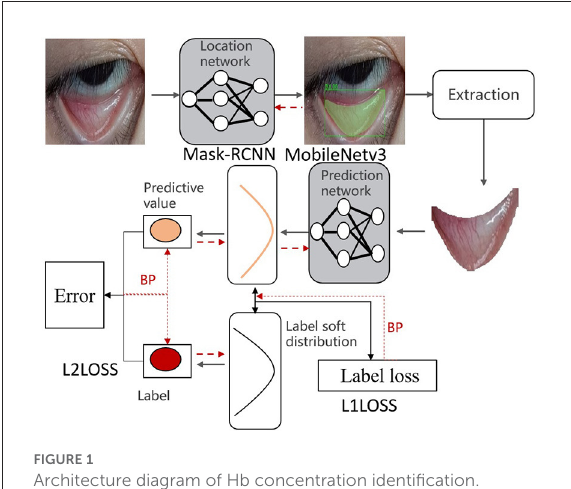
FIGURE1 Architecture diagram of Hb concentration identification.